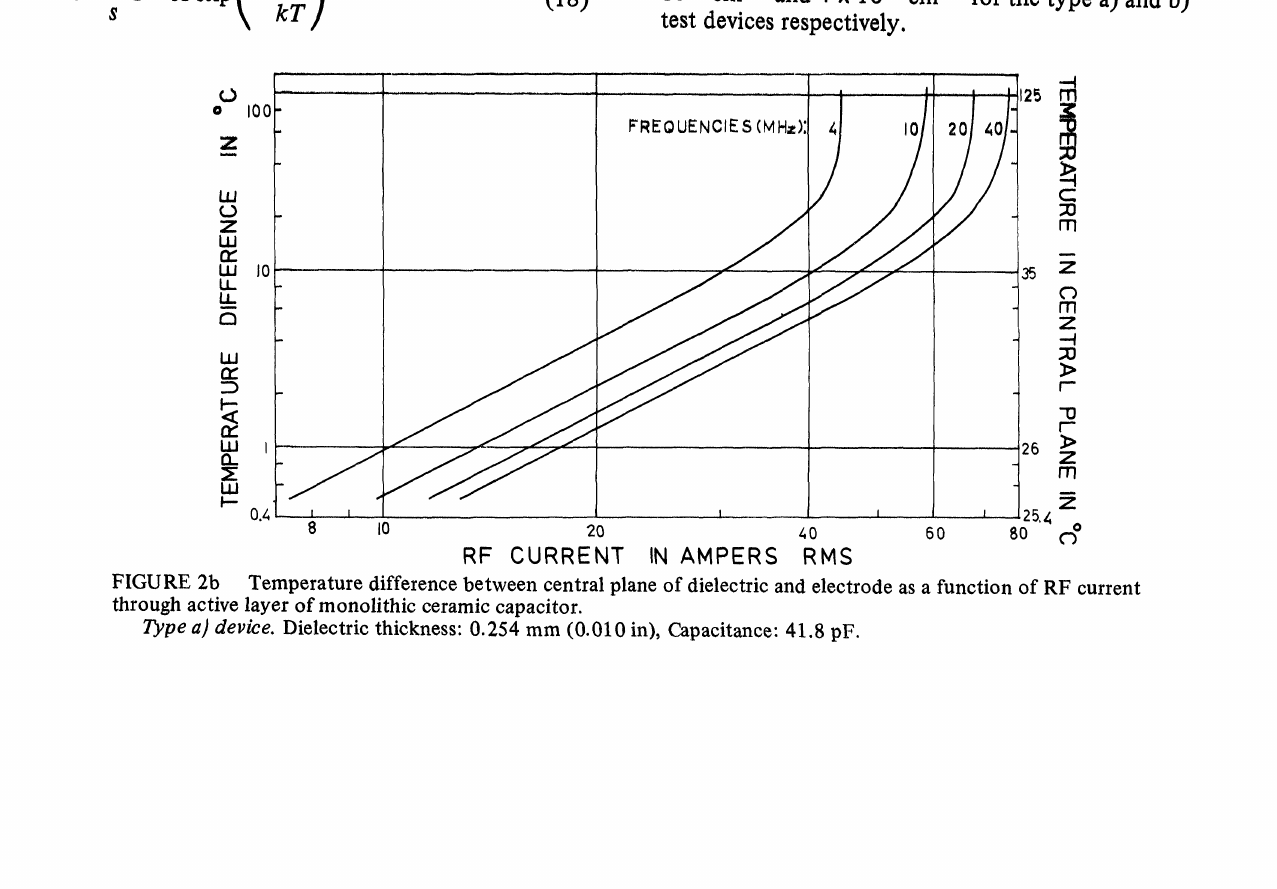
FIGURE 2a Temperature difference between central plane of dielectric and electrode as a function of RF voltage applied to the active layer of monolithic ceramic capacitor. Type a) device. Dielectric thickness: 0.254 mm (0.010 in), Capacitance: 41.8 pF.